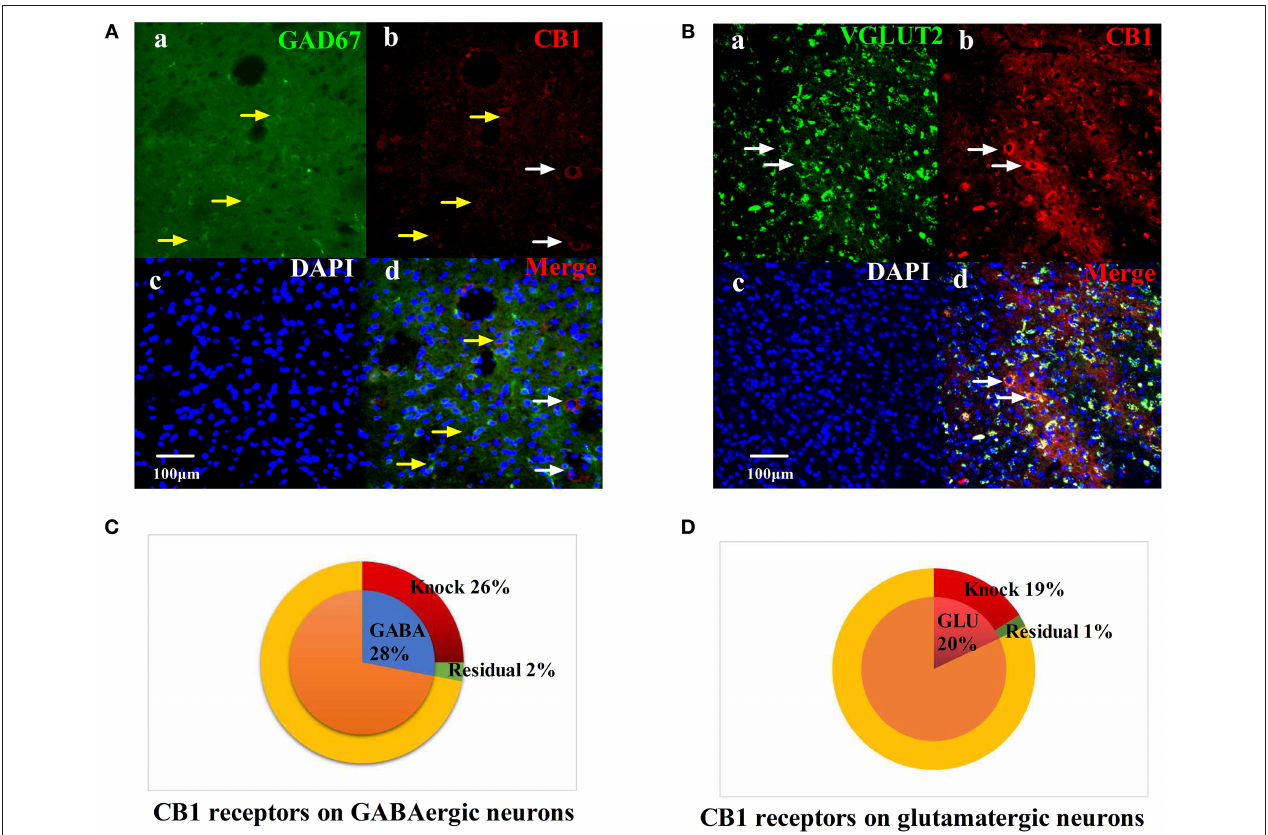
FIGURE 6 | Specific knockout of the CB1 receptor on GABAergic neurons localized in the vlPAG. (A) rAAV-mDlx-CRE-WPRE-pA was injected into the right side of the vlPAG of mCnr1flox/flox mice. (a) GABA-immunoreactive cellsin the vlPAG (green). (b) CB1-immunoreactive cells (red). (c) DAPI nuclear staining (blue). (d) GABA-immunoreactive and DAPI nuclear staining colocalization fluorescence (purple); Yellow arrows show CB1 receptors not knocked out on GABAergic neurons. White arrows show CB1 receptors not knocked out on other large diameter neurons. Scale bar, 100 µ m. (B) rAAV-CaMKII-CRE-WPRE-pA was injected into the right side of the vlPAG of mCnr1flox/flox mice. (a) GLU-immunoreactive cells (green). (b) CB1-immunoreactive cells in the vlPAG (red). (c) DAPI nuclear staining (blue). (d) GLU-immunoreactive and DAPI nuclear staining colocalization fluorescence (purple); White arrows show CB1 receptors not knocked out on glutamatergic neurons. Scale bar, 100 µ m. (C) Summary data show that the percentage of CB1-immunoreactive cells was knocked out in the area of GABA-immunoreactive cells. Blue sector, GABA-immunoreactive cells; red sector, CB1-immunoreactive cells were knocked out; green sector, residual cells. (D) Summary data shows the percentage of CB1-immunoreactive cells knocked out in the area of glutamatergic-immunoreactive cells. Pink sector, glutamatergic-immunoreactive cells; red sector, CB1-immunoreactive cells been knocked out; green sector, residual cells. Data are expressed as the means ± SEM ( n = 3 mice in each